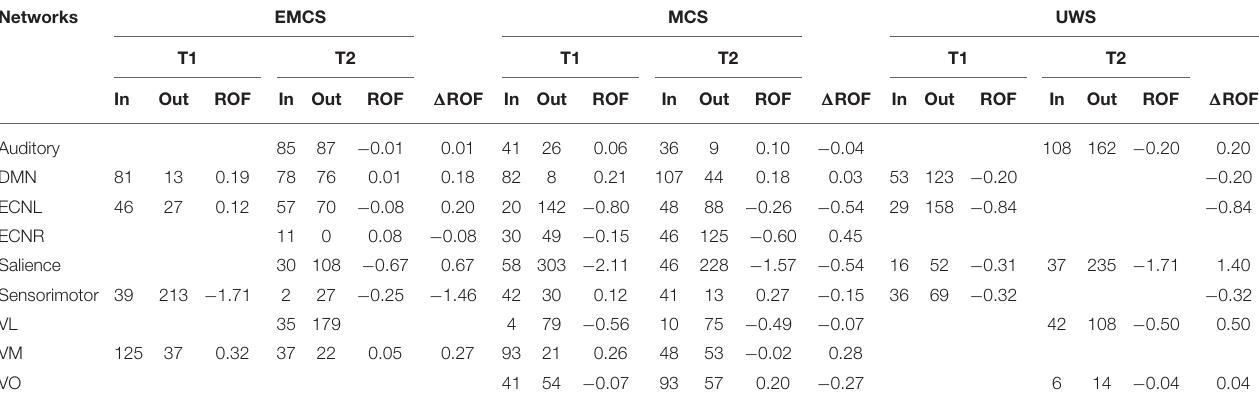
TABLE 1 | ROF values calculated from regions belonging to the GS values, separated into the regions belonging to the network itself and outside the network. Networks EMCS